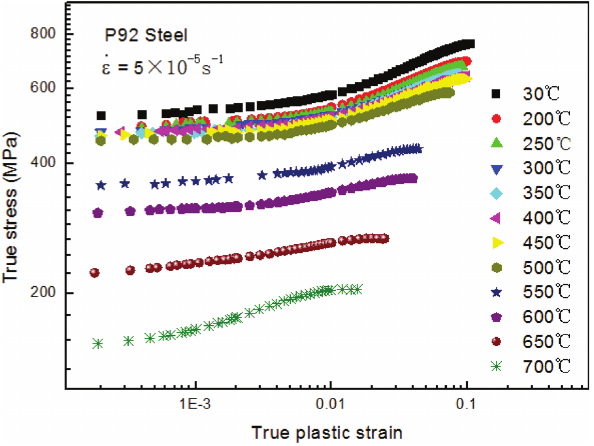
Figure 3: True stress – true plastic strain curves of P92 steel at strain rate of 5 × 10 − 5 s − 1